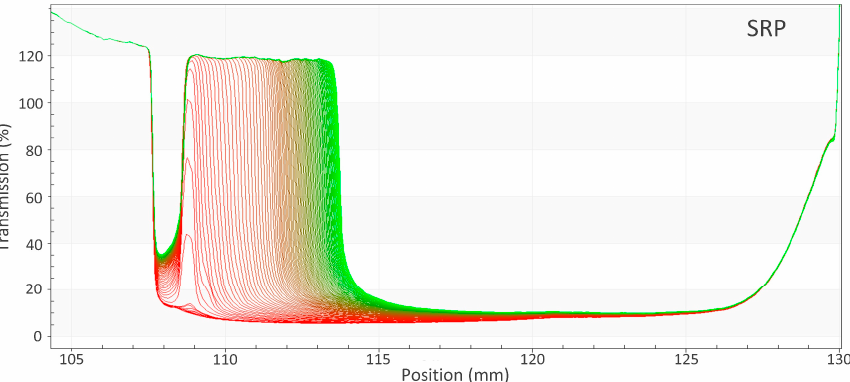
Figure A1. Transmission profiles of the stable recycled paint, SRP (6 h at 300× g ).